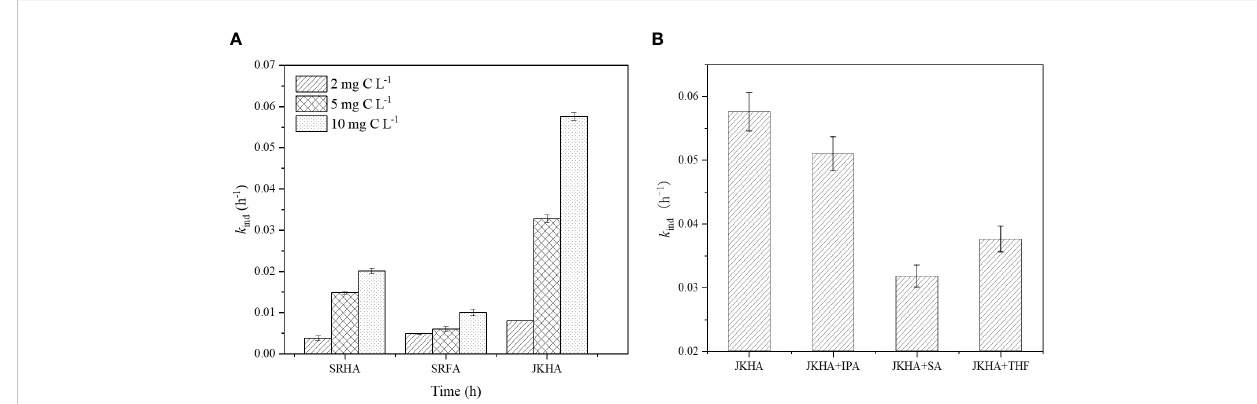
FIGURE 2 Indirect photodegradation rate of OFX. (A) In the presence of different DOMs. (B) With the addition of IPA (5 mM), THF (2 mM), and SA (20 mM) in JKHA solution (10 mg C L − 1 ). The data were presented as mean; error bars denote standard deviations (p< 0.05, n = 3). OFX, o fl oxacin; DOM, dissolved organic matter; IPA, isopropanol; THF, tetrahydrofuran; SA, sorbic acid.